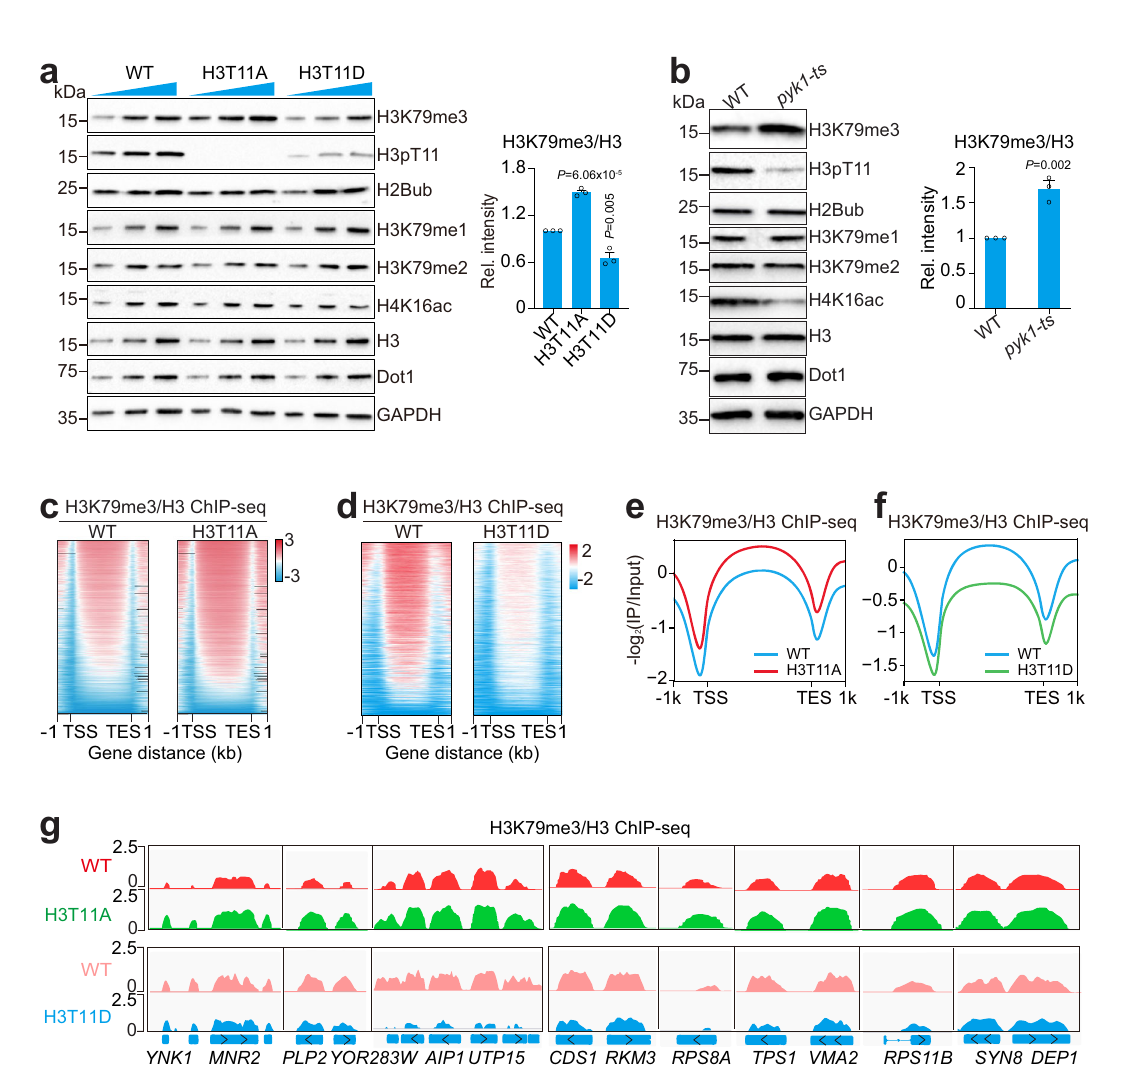
Fig. 2|LossofSESAME-catalyzedH3pT11increasesDot1-catalyzed H3K79me3. a Immunoblot analysis of histone modi fi cations and Dot1 in WT, H3T11A and H3T11D mutants when grown in YPD medium until OD 600 of 1.0. b Immunoblot analysisofhistone modi fi cations and Dot1 in WT and pyk1-ts mutants when grown in YPD medium at non-permissive temperature (39°C) for 2h. c Distribution of H3K79me3acrosseachgenethrough1kbupstreamoftheTSSto1kbdownstream from the TES at all genes in WT and H3T11A mutant. d Distribution of H3K79me3 across each gene through 1kb upstream of the TSS to 1kb downstream from the